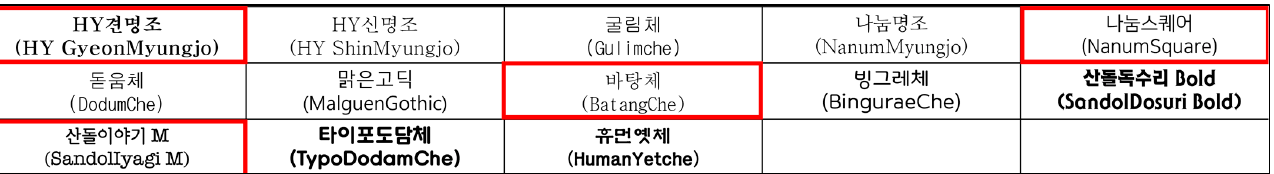
Table 6. User Survey Examples.